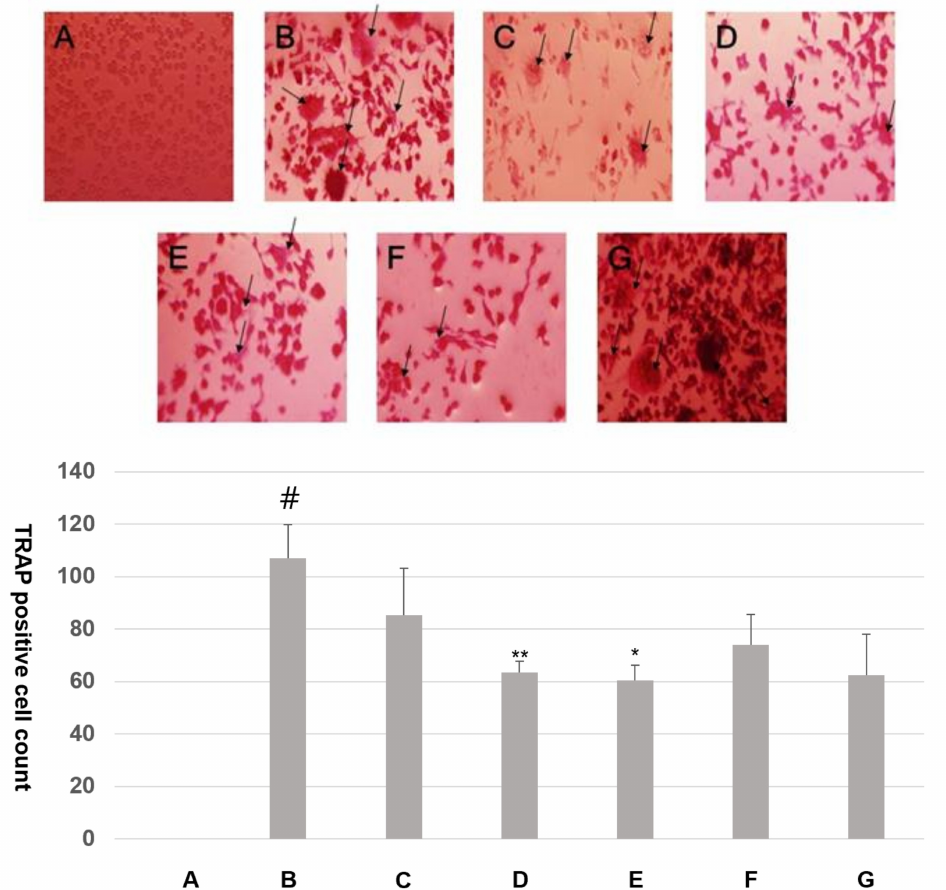
Figure 5. Osteoclast differentiation in osteoclast precursor RAW 264.7 cells: ( A ) Control; ( B ) RANKL 50 ng/mL + M-CSF 30 ng/mL; ( C ) RANKL/M-CSF + PE 100 µ g/mL; ( D ) RANKL/M-CSF + FPE 100 µ g/mL; ( E ) RANKL/M-CSF + DHD 10 µ g/mL; ( F ) RANKL/M-CSF + EQ 10 µ g/mL; ( G ) RANKL/M-CSF + E 2 10 − 9 M 48 h after treatment. # p < 0.01 compared to control. * p < 0.05 compared to RANKL 50 ng/mL + M-CSF 30 ng/mL group. ** p < 0.01 compared to RANKL 50 ng/mL + M-CSF 30 ng/mL